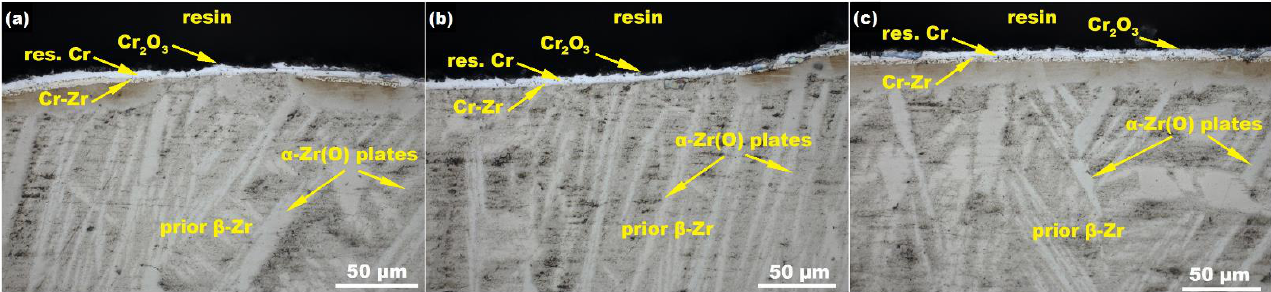
Figure 2. OM images of the cross-section microstructure of the Cr-coated LBW sample after 90 min oxidation in a surface region of WZ ( a ), HAZ ( b ), and bulk ( c ) zones.